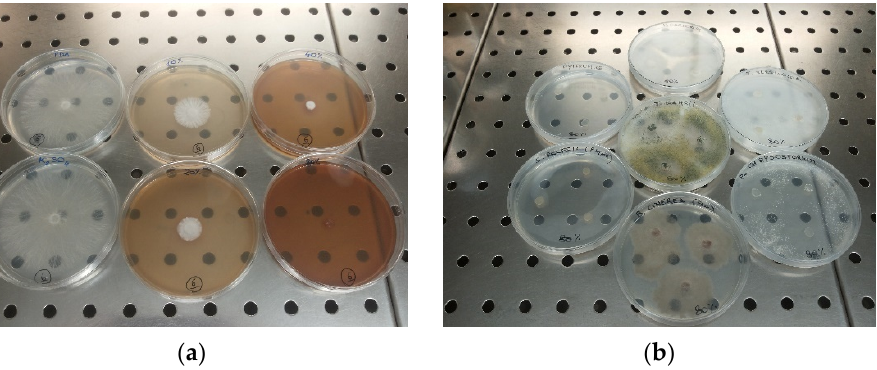
Figure 2. ( a ) Effect of the increasing doses of the giant reed extract on the colony growth of a representative isolate ( Sclerotium rolfsii ); ( b ) test of the growth-recovery of different isolates on unamended medium after the occurrence of total inhibition on substrate amended with the giant reed extract.